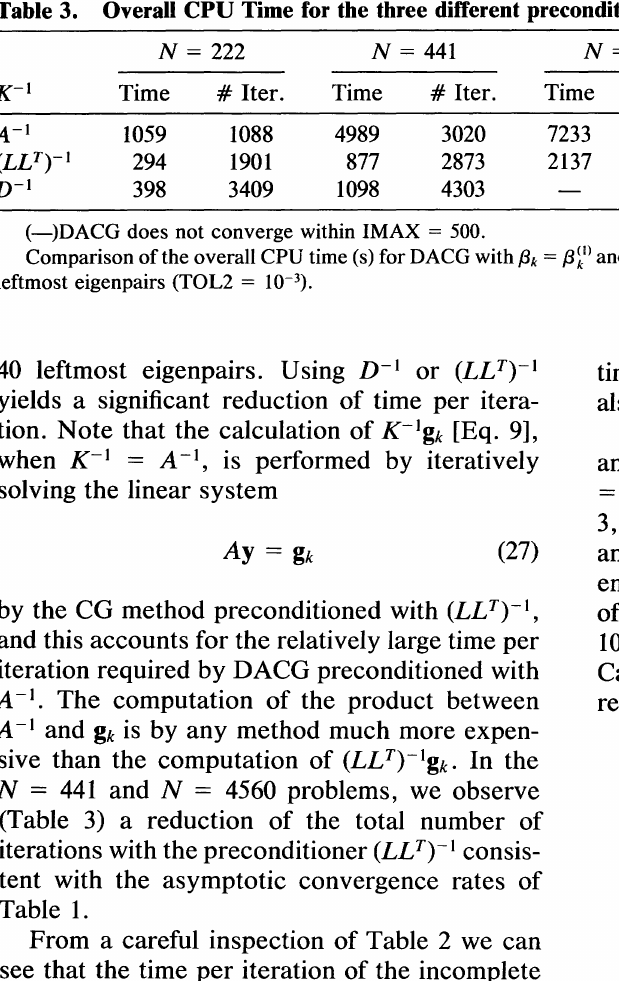
Table 3. Overall CPU Time for the three different